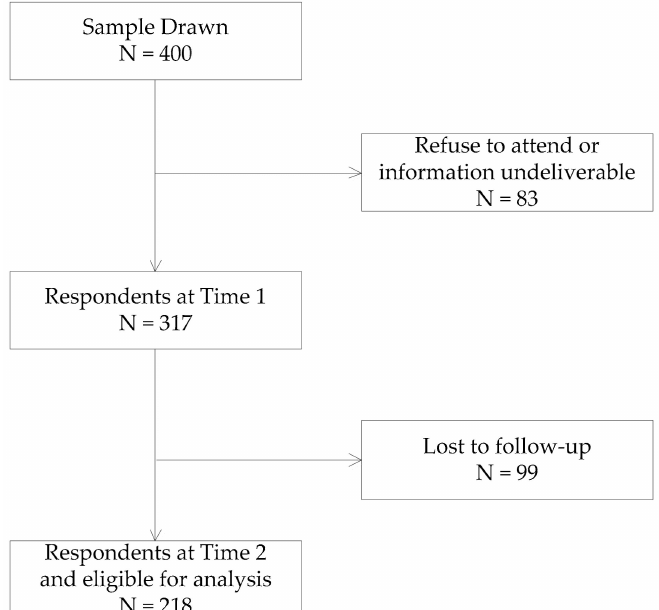
Figure 2. Flow of the study samples included in the current